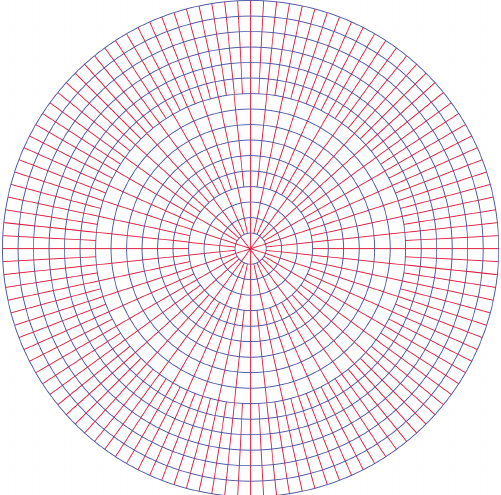
Figure 4. For the polar regions the number of grid columns is re- duced by two each time the spacing between lines of latitude is